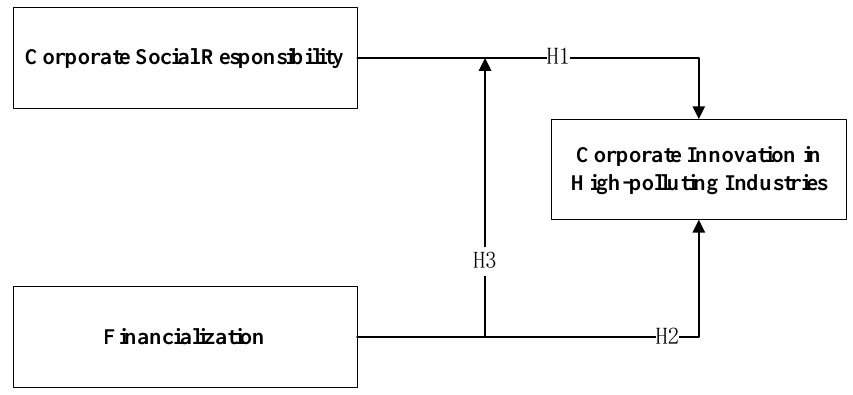
Figure 3. Research model.